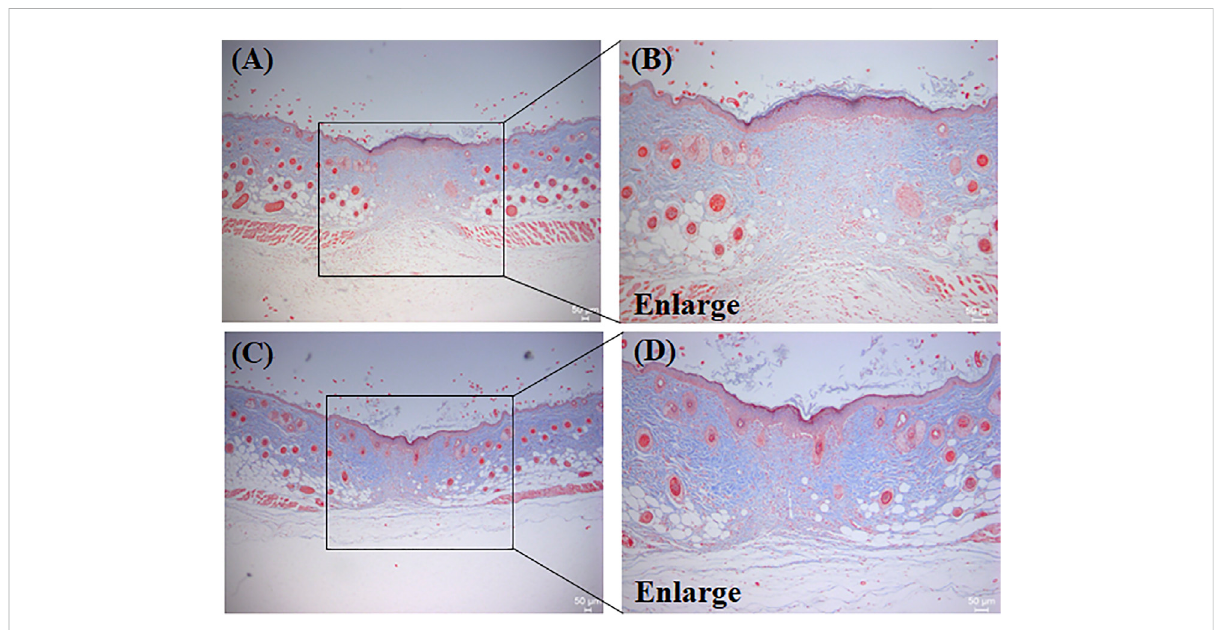
FIGURE 9 Masson staining results of mouse dorsal skin tissue protected by (A) PBS and (C) the water-based PEG/CS composite lubricant. (B) and (D) are magni fi ed images of the corresponding boxed